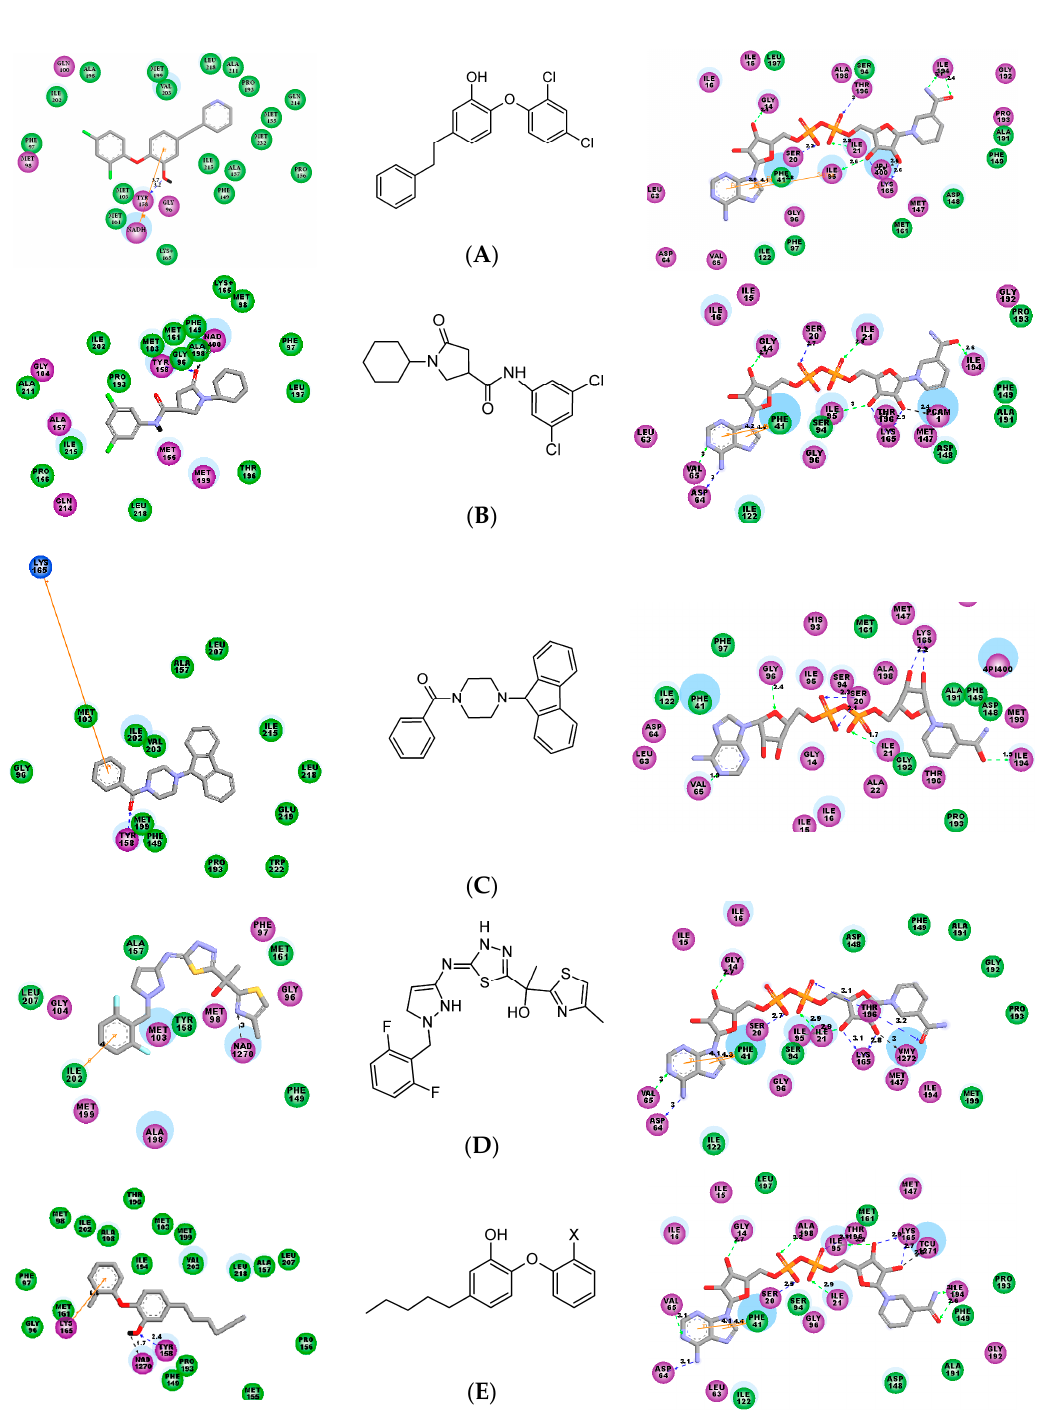
Figure 2. ( Left ) 2D interaction diagram of designed nanomolar enoyl-acyl carrier protein reductase (InhA) inhibitors. Middle: most important affinity features: van der Waals, σ – π , π – π , cation– π (orange line), hydrogen bonds (HBs) (black, blue and green dashed line) and hydrophobic; ( Right ) pertinent nicotinamide adenine dinucleotide (NADH) conformation. ( A ) Triclosan ( IC 50 = 21 nM), HB: Tyr158, π – π : NAD, PDB: 3FNH [9]; ( B ) Pyrrolidine carboxamide ( IC 50 = 390 nM), HB: Tyr158 and NAD, PDB: 4U0J [12]; ( C ) Aryl amides ( IC 50 = 90 nM), cation– π : Lys165, 2NSD, in situ modified [13]; ( D ) Methyl Thiazole ( K d = 13 nM), HB: NADH, σ – π : Ile202, 4BPQ [1]; ( E ) Alkyl diphenyl ether, ( K i = 22 pM), HB: Tyr158, NADH, cation– π : Lys165, 2X23 [11]. Active site residues are presented in balls colored by interaction type (green for van der Waals, magenta for polar, charge and hydrogen bond while light blue for water or solvent accessible surface).